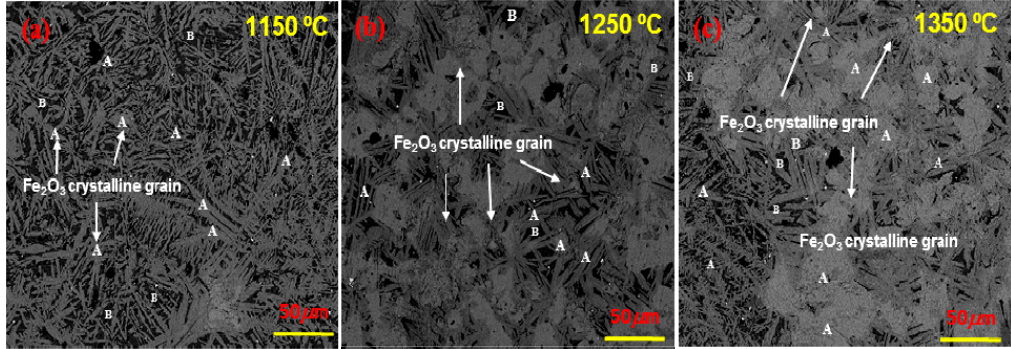
Figure 9. Micro-structure of pellets: ( a ) 1150 °C; ( b ) 1250 °C; ( c ) 1350 C. A is (Fe 2 O 3 crystalline grain); B is (Un-oxidation Fe 3 O 4 ).